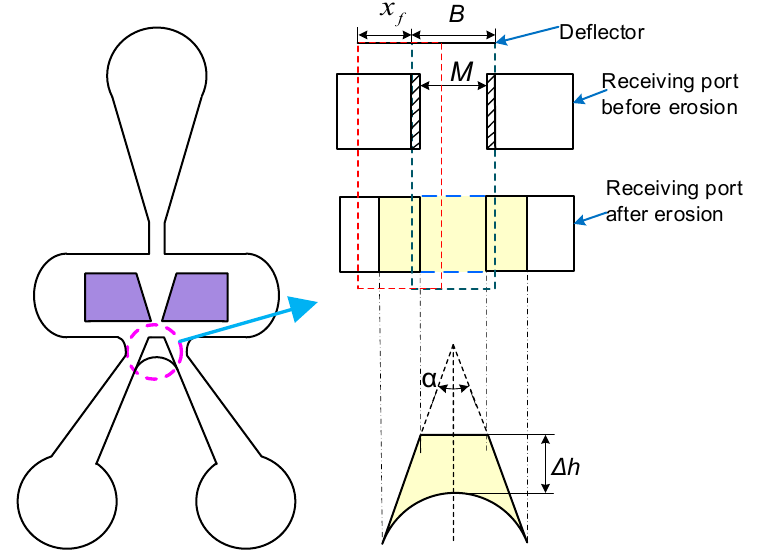
Figure 14. The structure of pre ‐ stage after erosion.